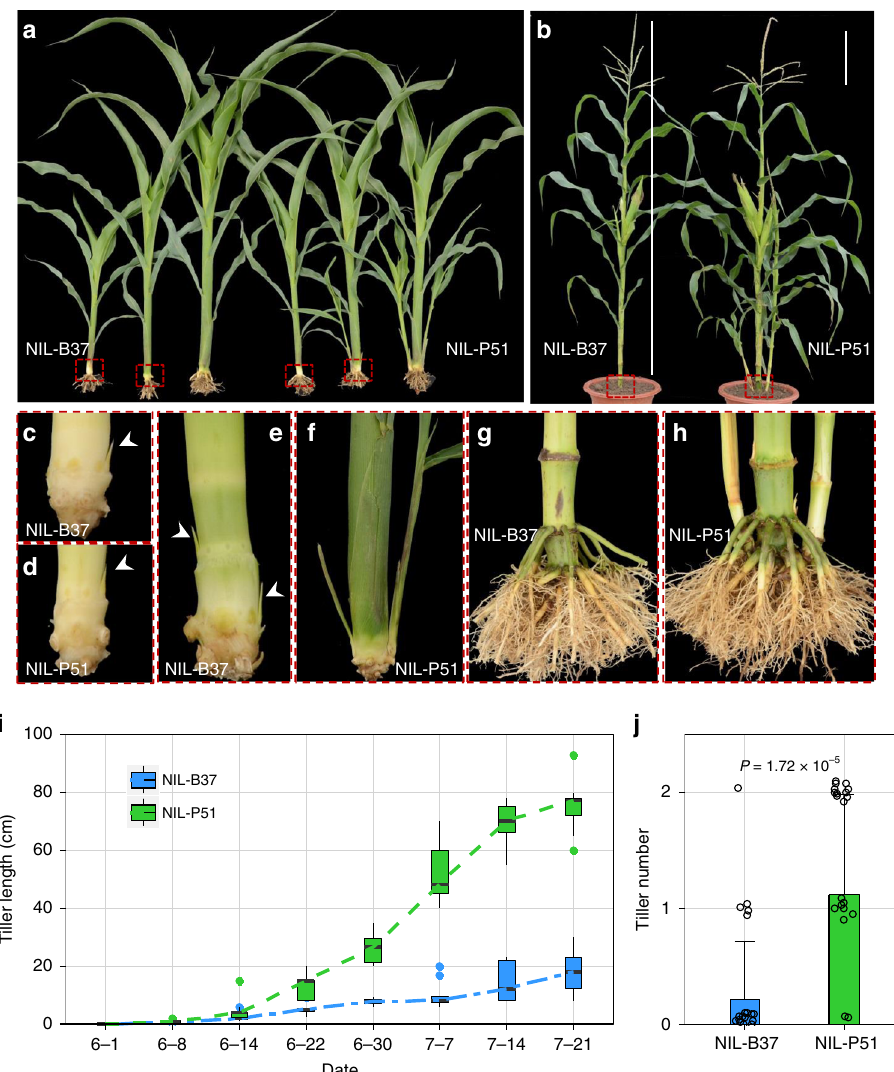
Fig. 2 Phenotypes of maize tin1 . a , b Phenotype comparisons between two near-isogenic lines (NILs) before the jointing stage ( a ) and at the fl owering stage ( b ). c – f A close-up view of the tiller base at 25 ( c, d ) and 35 ( e , f ) days after planting (DAP) in NIL-B37 ( c , e ) and NIL-P51 ( d , f ). The tiller buds from NIL- B37 remained dormant all the time ( e ), while the tiller bud from NIL-P51 grew out at 35 DAP ( f ). g , h A close-up view of the tiller base at fl owering stage from NIL-B37 ( g ) and NIL-P51 ( h ). i Growth curves of tiller bud development from NIL-B37 (blue) and NIL-P51 (green). Box edges represent quartiles, and the medians were shown with the central line in the boxes. j Final tiller number in NIL-B37 (blue) and NIL-P51 (green). Error bar, SD ( n = 28, 26). P -values were determined by two-tailed Student ’ s t -test. Scale bar, 25 cm. The source data underlying i , j are provided as a Source Data fi